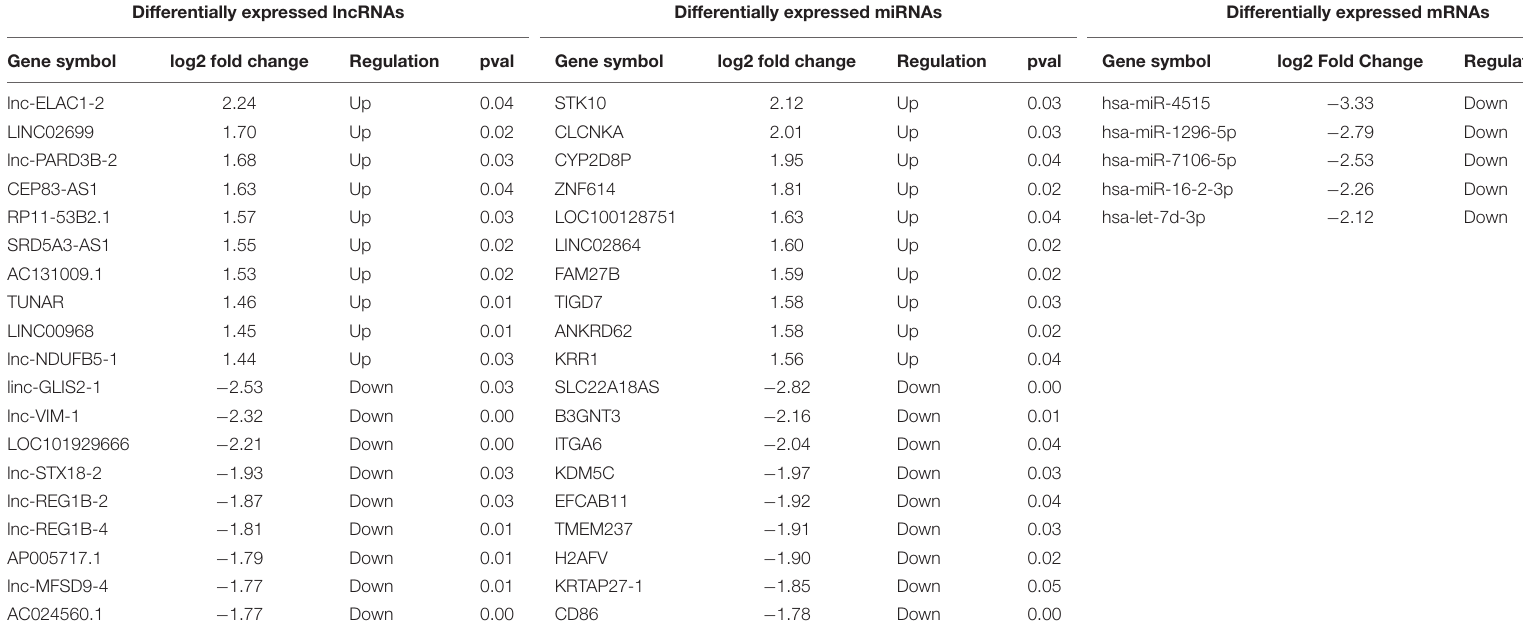
TABLE 1 | Differentially expressed lncRNAs, mi RNA and mRNA in the plasma of REP patients. Differentially expressed lncRNAs Differentially expressed miRNAs Differentially expressed